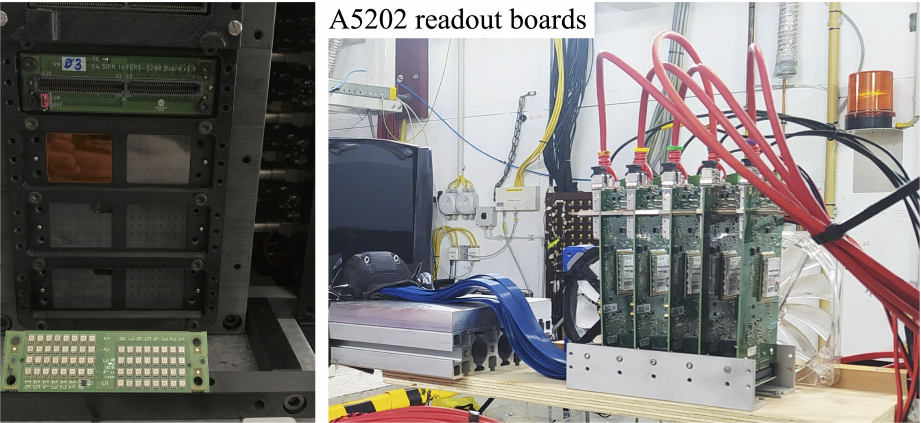
Figure 2. The picture on the ( left ) shows the back side of the highly granular module and a front-end board with 64 SiPMs before the installation. The system, ready to take data and connected to the five A5202 boards requested to operate the SiPMs, is shown on the ( right